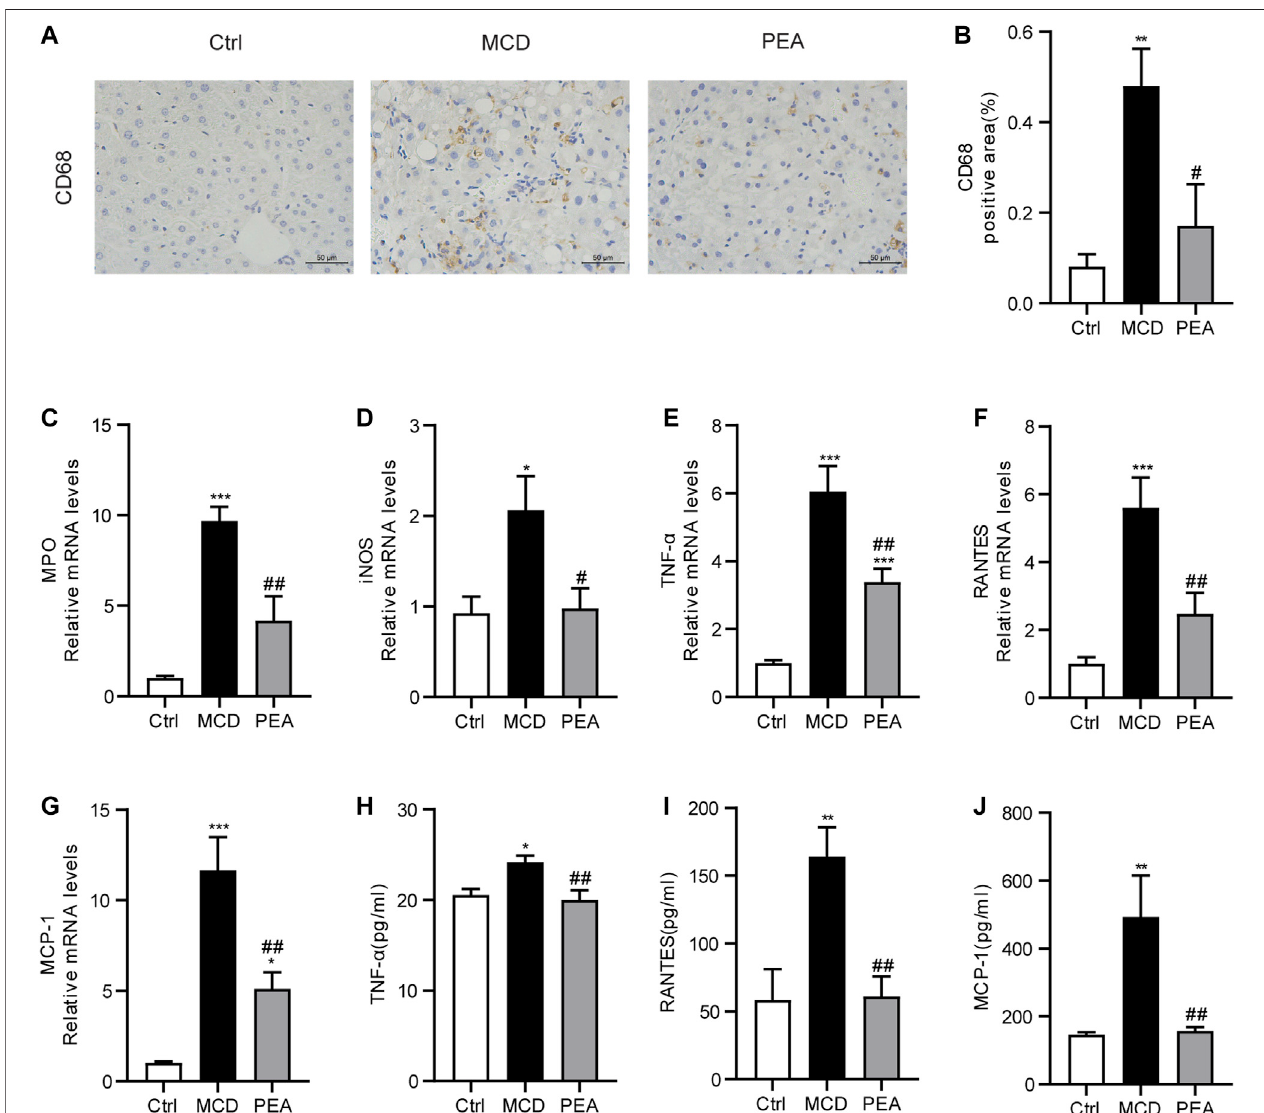
FIGURE 4 | PEA ameliorated hepatic in fl ammation in mice fed by MCD diet. (A,B) Macrophage distribution in the liver was identi fi ed by staining of CD68 ( × 400). The mRNA expression levels of (C) MPO, (D) iNOS, (E) TNF- α , (F) RANTES, and (G) MCP-1 in the liver measured via qRT-PCR. (H – J) The protein levels of TNF- α , RANTES, and MCP-1 in plasma detected by ELISA assay. Ctrl: the mice treated with standard diet; MCD: the mice treated with MCD diet; PEA: the mice treated with MCD diet and PEA.Values wereexpressed asthemean ± SEM, n (cid:1) 6 – 8foreach group. * p < 0.05,** p < 0.01, *** p < 0.001 versusthe Ctrlgroup; # p < 0.05,## p < 0.01 versus the MCD